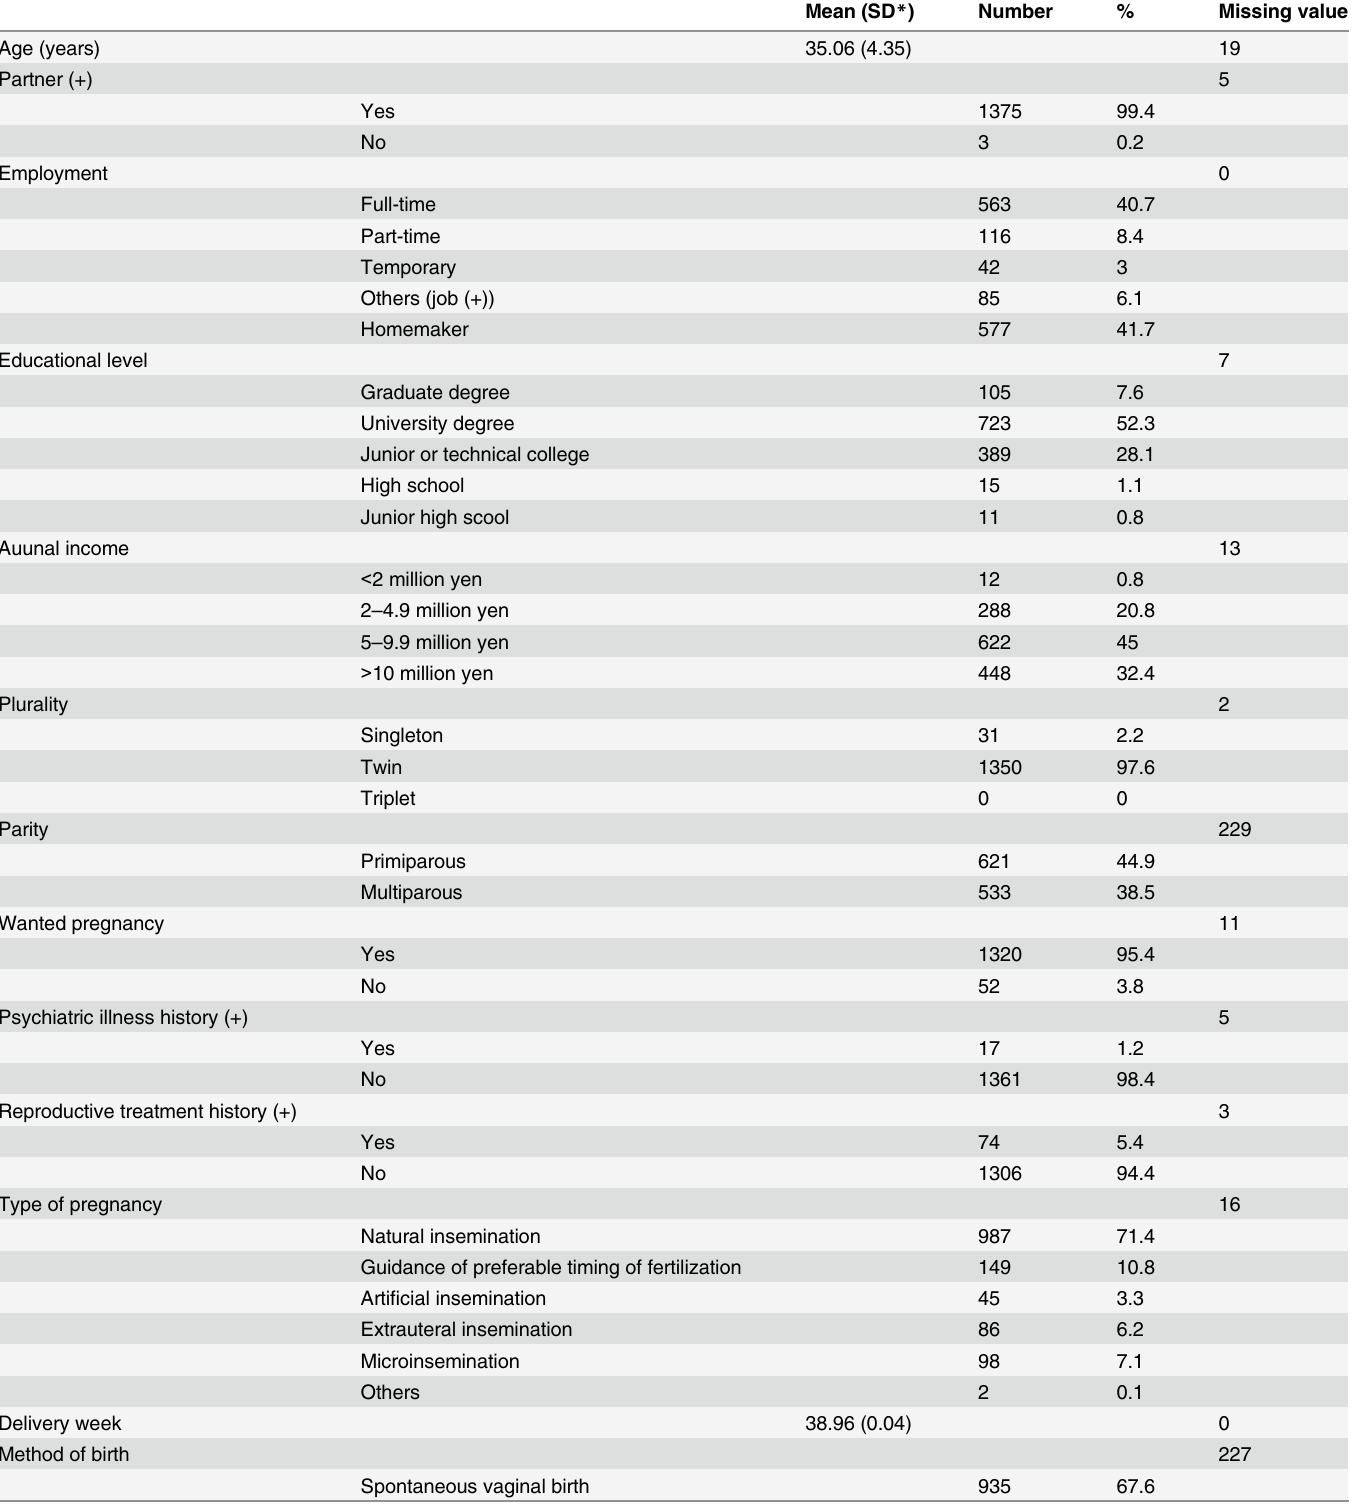
Table 1. Basic characteristics of the